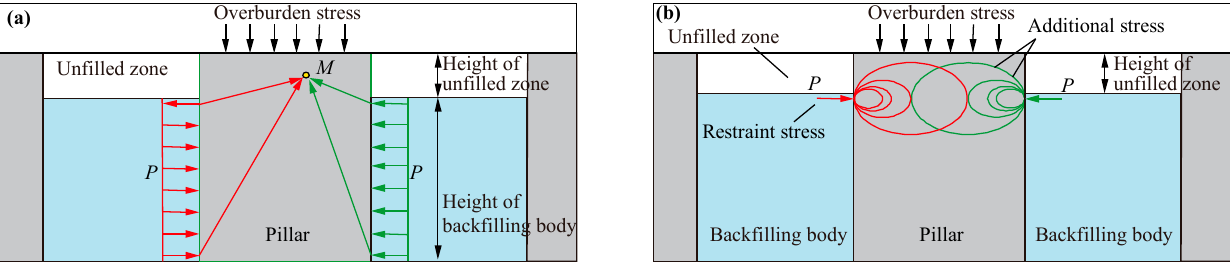
Figure 6. Mechanical model of lateral restraint of filling material. ( a ) Coal pillar force model, ( b ) half-plane model.